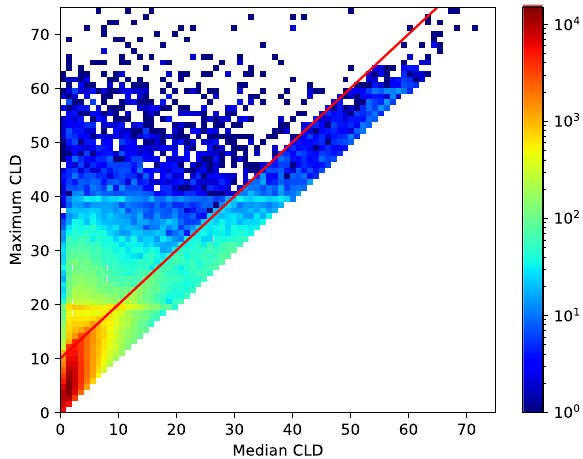
Fig. 9 Median CLD versus maximum CLD two-dimensional histogram. We plot a two-dimensional histogram of users ’ median CLD versus maximum CLD in logarithmic space, as well as the line where maximum CLD is equal to median CLD plus 10 in red. We can see that the line separates out a highly concentrated region of users, as well as a more scattered region of users. Speci fi cally, the majority of the mass falls under this line, as showcased by the concentrated red color in the lower left-hand corner of the plot, and a diagonal band extending upward, while the region above the line is more spread out. Thus, we examine the cycles that fall above the line as possible cycle tracking